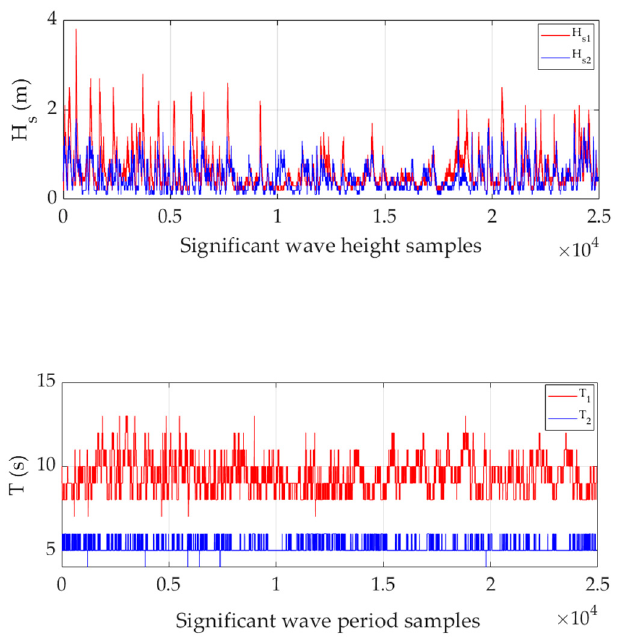
Figure 1. 2015 ground truth ocean wave data input time series with 20-min time step, swell (H s1 , T 1 ) and wind waves (H s2 , T 2 ).